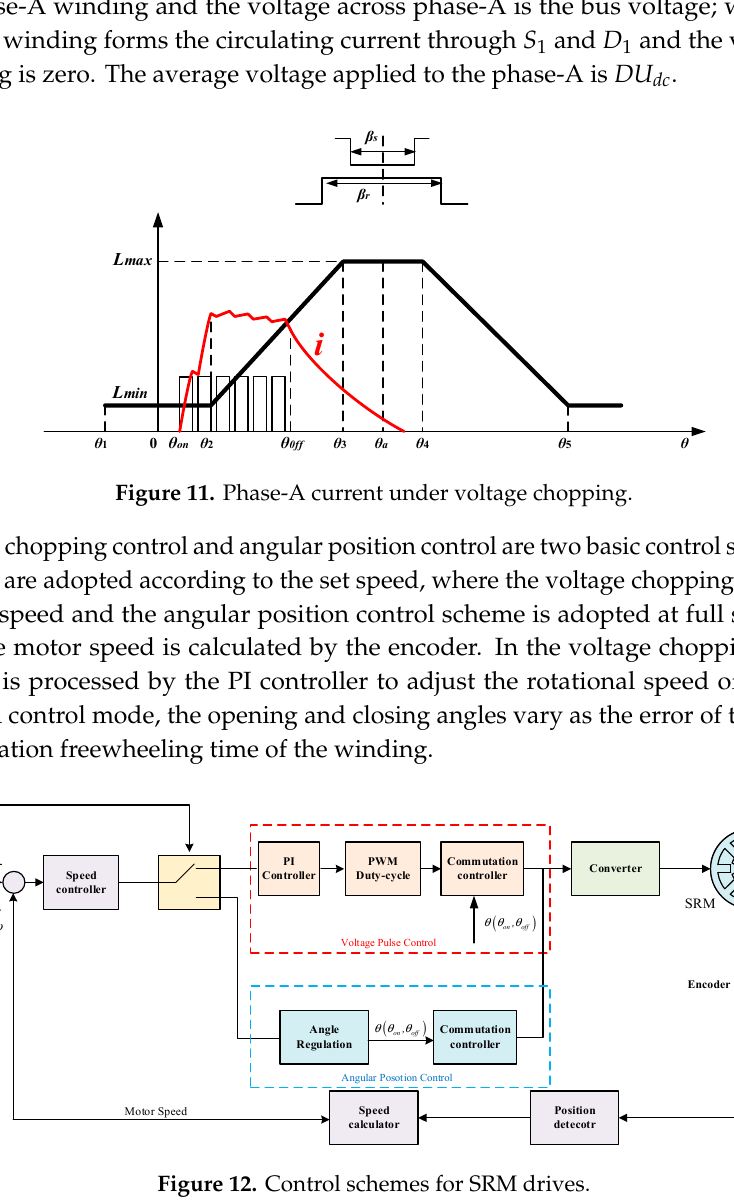
Figure 12. Control schemes for SRM drives.